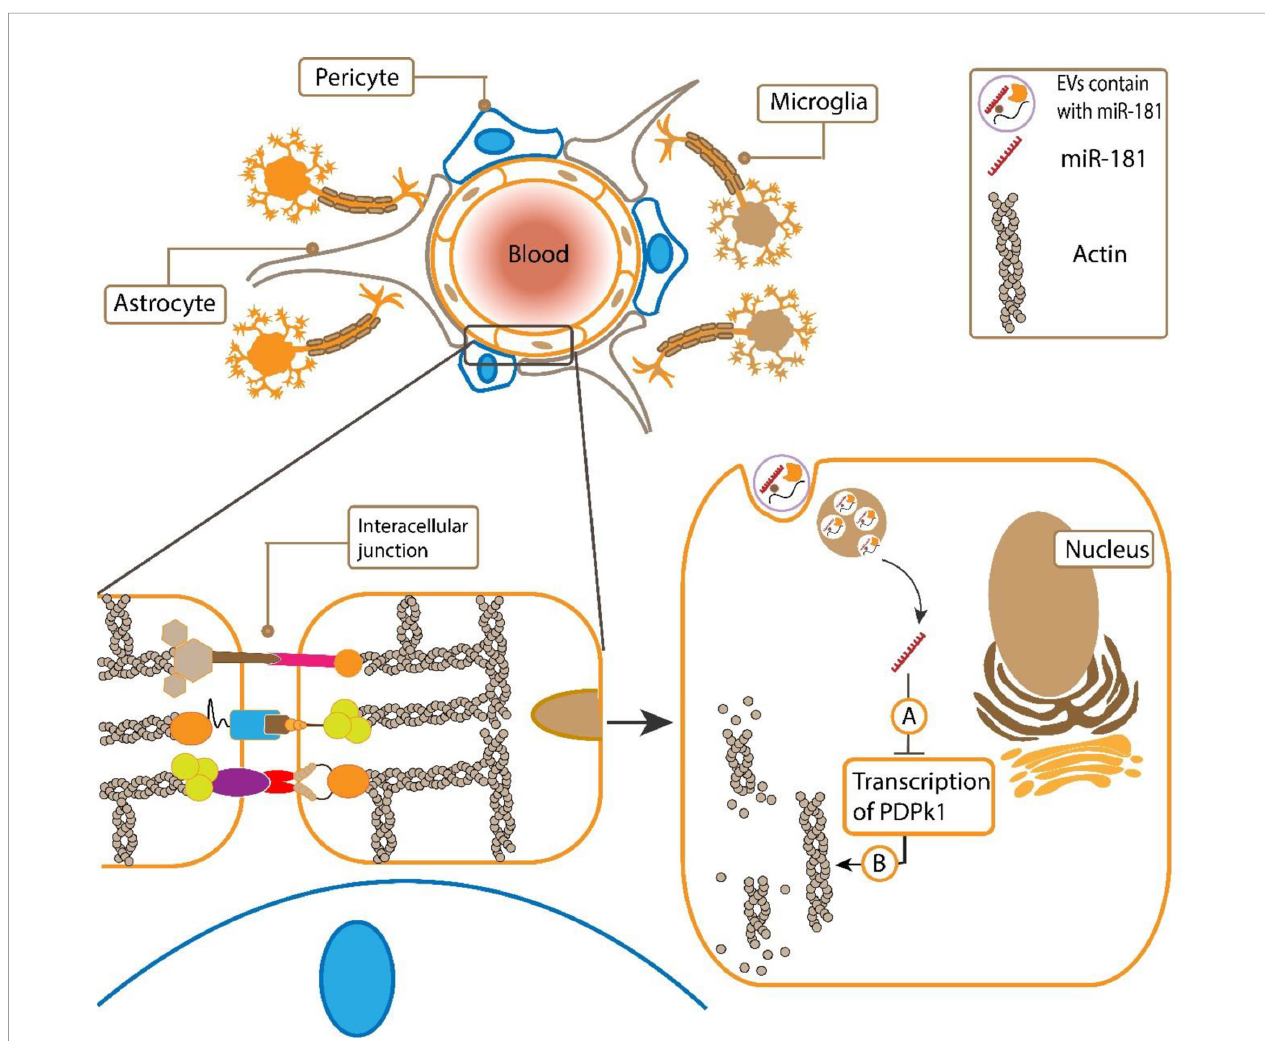
FIGURE 2 | (A) miR-181c that secreted from metastatic breast cancer cells could transfer by exosomes to epithelial cells and suppresses the expression of PDPK1. (B) Then, it results in activated co fi lin which disassembles actin fi laments and makes the BBB permeable. Following, cancer cells could cross the